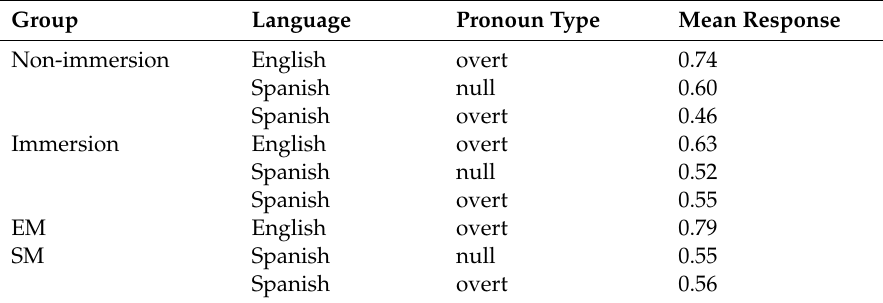
Table 5. Total of mean expected responses by